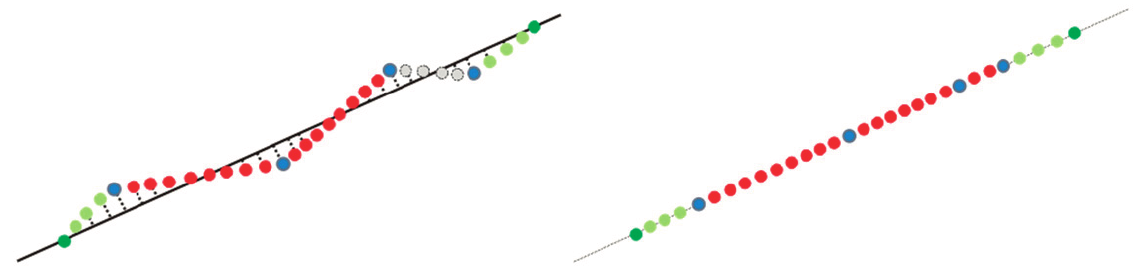
Figure 8. Algorithm of sorting and completing edge points, Method 2